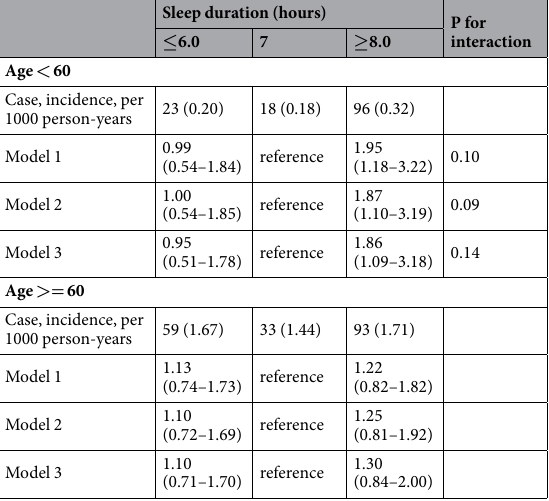
Table 4. Hazard ratios (95% CI) for atrial fibrillation according to sleep duration stratified by age in the Kailuan Study. Model 1: Adjusted for age and sex. Model 2: Adjusted for age, sex, level of education, smoking, alcohol, physical activity, and body mass index. Model 3: Adjusted for variables in Model 2 plus hypertension, diabetes mellitus, dyslipidaemia, myocardial infarction, uric acid, and high-sensitivity C-reactive